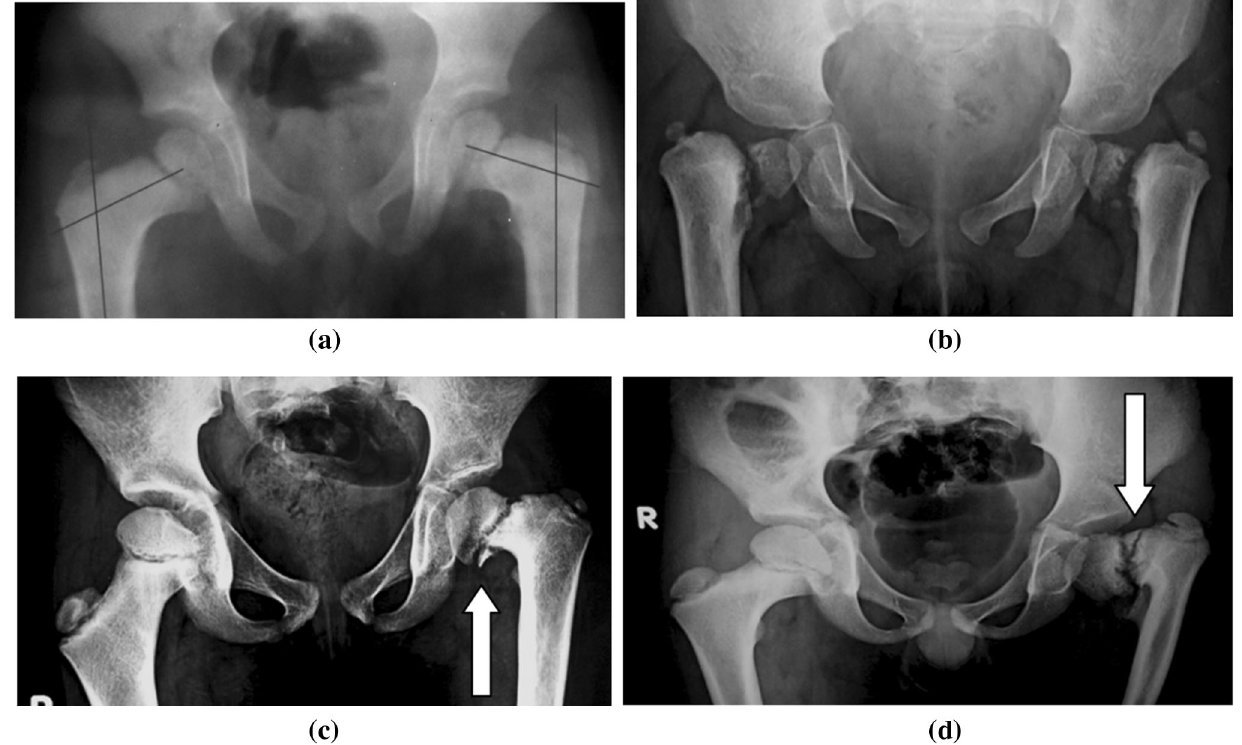
Fig. 1 Standard AP radiographs of the pelvis and both hip joints showing different etiologies and severities of coxa vara. a Bilateral coxa vara following healed rickets. b Bilateral developmental coxa vara with a medial femoral neck defect and a vertically oriented